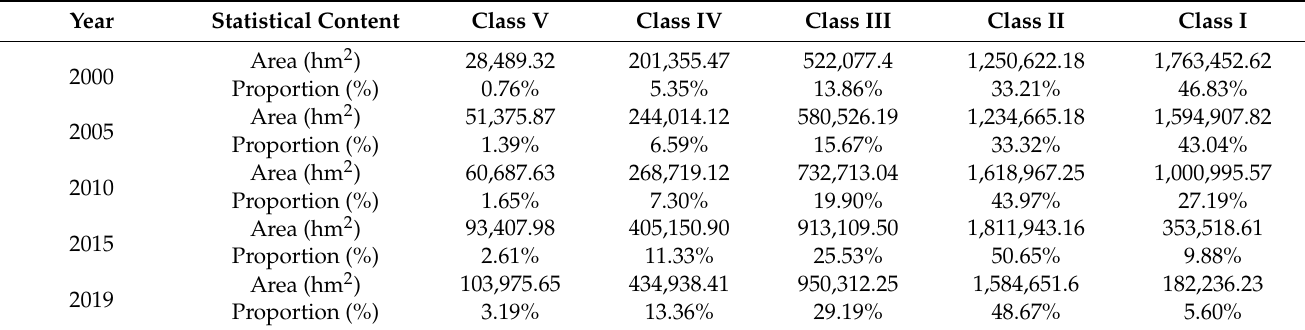
Table 5. Statistics of cultivated land area of different levels of cultivated land system